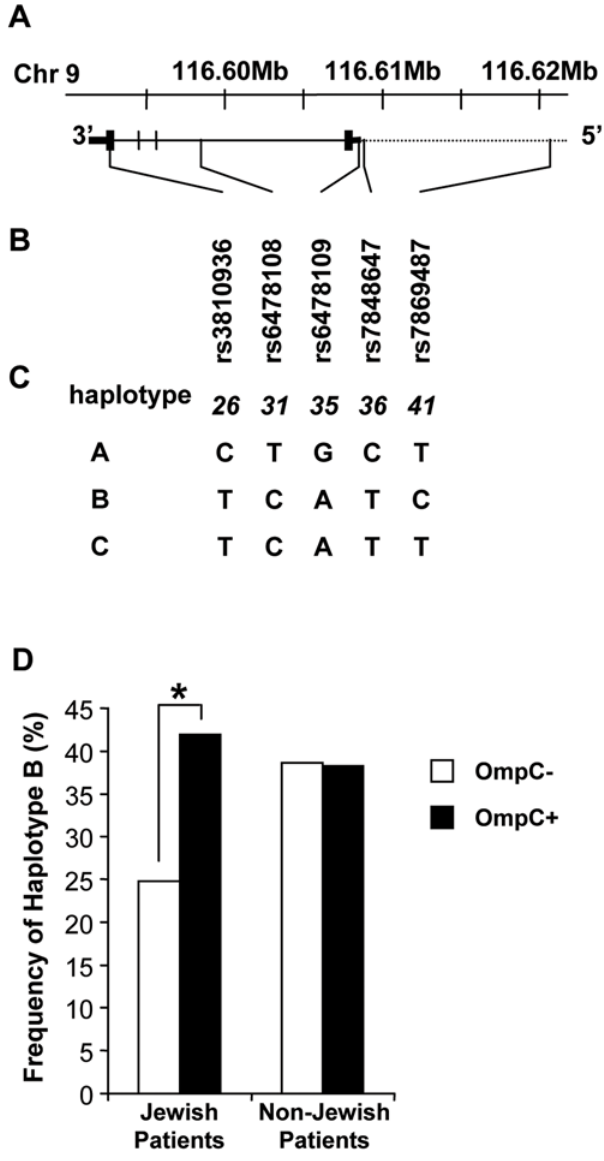
Figure 1. TL1A (TNFSF15) gene and haplotype structure and association with Crohn ’ s Disease. ( A ) The TNFSF15 gene is on the reverse strand of NCBI human genome build 36 at the position shown on chromosome 9 but is shown 5 9 to 3 9 in keeping with the previous reports. The dotted line represents genomic sequence, solid line the gene sequence, thin bars untranslated regions, and thick bars the exons. ( B ) Single nucleotide polymorphisms (SNPs) genotyped for this study are listed with their relative positions along the gene. ( C ) Definition of haplotypes assigned in this study. The nucleotide assignments follow the previous report and correspond to the sense strand of the gene. The numbers 26, 31, 35, 36, and 41 refer to previous reports [12]. ( D ) Frequency of CD patients as a function of OmpC status for TL1A haplotype B for Jewish and non-Jewish CD patients, respectively (P # 0.001). doi:10.1371/journal.pone.0004719.g001 B haplotype , respectively (data not shown). Jewish OmpC 2 patients carrying the B haplotype also secreted higher levels of TL1A in response to IC than A carriers at 6 h post stimulation (Figure 4B, p = 0.054 for 16 h IC stimulation), while non-Jewish OmpC + patients with the B haplotype secreted higher levels of TL1A at 16 h